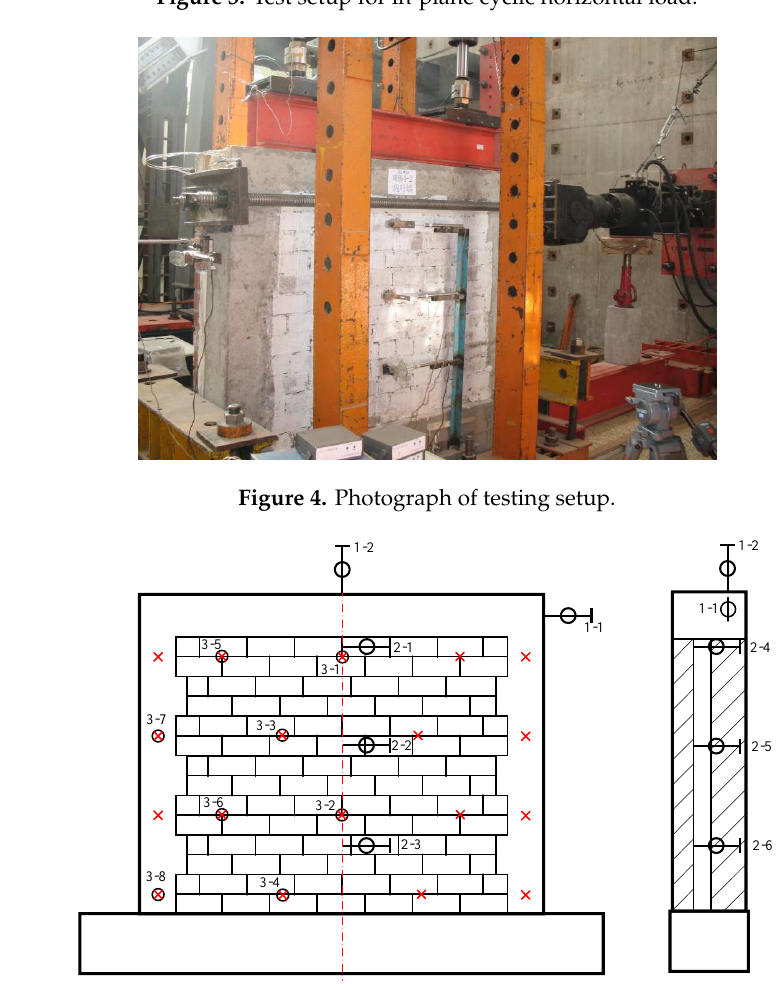
Figure 6. Loading history.